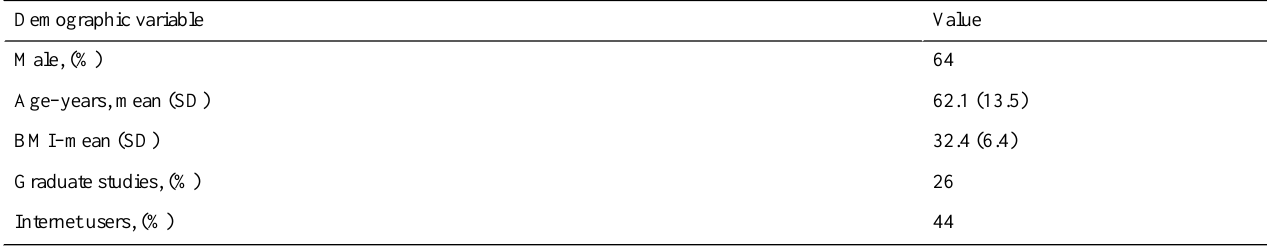
Table 1. Demographic characteristics of patients included in study 1